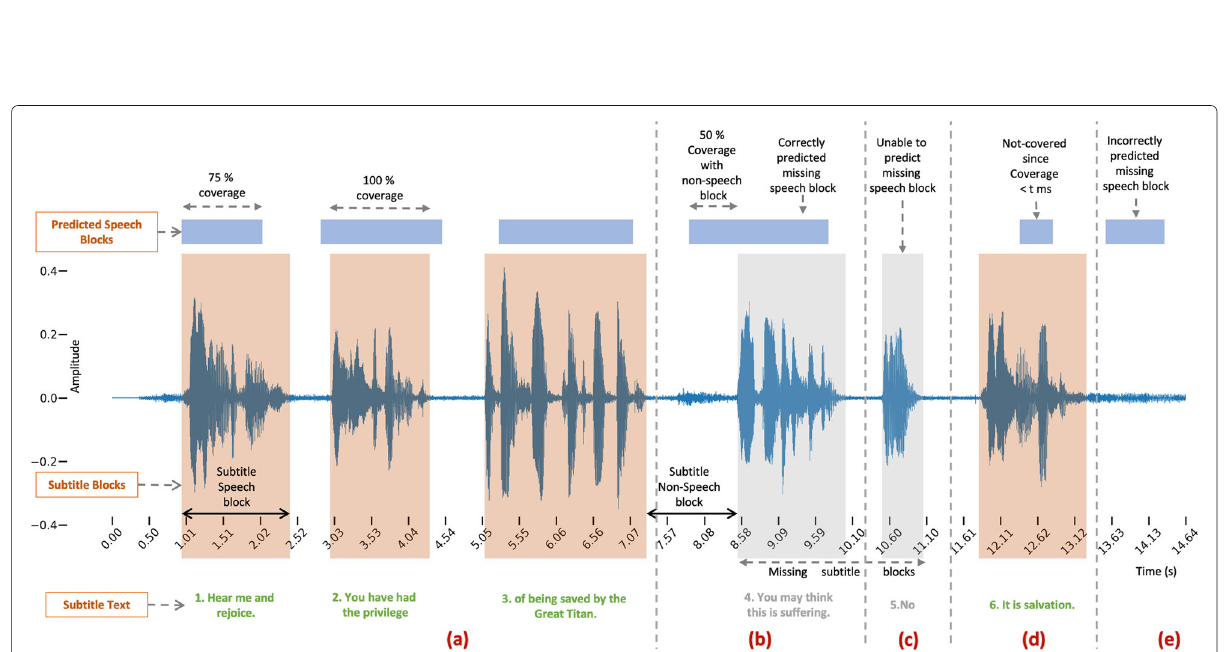
Fig. 6 The figure depicting subtitle speech blocks in peach (overlaid on audio track) in the middle, predicted speech blocks in blue at the top and subtitle text at the bottom. The figure highlights several output cases of our algorithm: a the coverage of predicted speech blocks (blue) with the subtitle speech blocks (peach), b the subtitle non-speech block, missing subtitle speech block (in light gray) and predicted speech block that correctly predicts the missing subtitle location but overlaps with the non-speech segment as well, c our algorithm is unable to predict the missing speech block, d our algorithm makes a prediction with coverage < t ms and hence fails to detect the speech block, and e the algorithm falsely identifies a non-speech region as